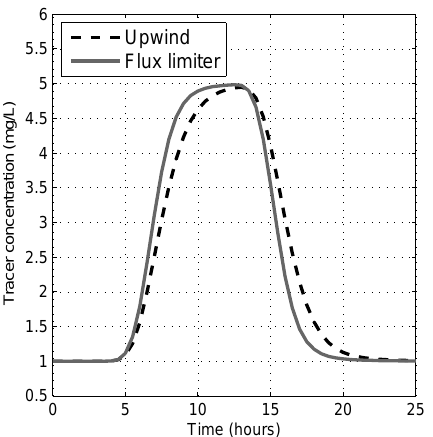
Fig.9: PulseofapassivetracerattheDeltaoftheRiverJacu´ı. Fig. 9. Pulse of a passive tracer at the Delta of the Jacuí